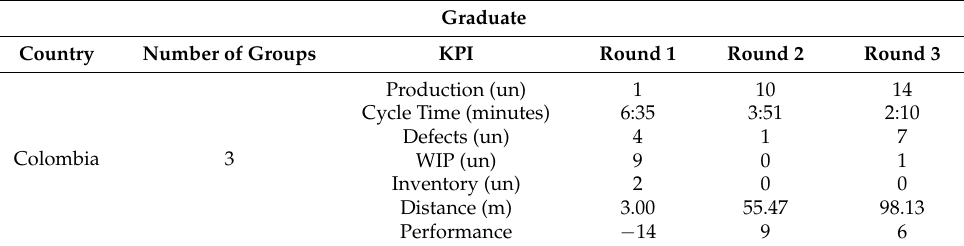
Table 8. Key performance indicators measured in the application of the game to graduate